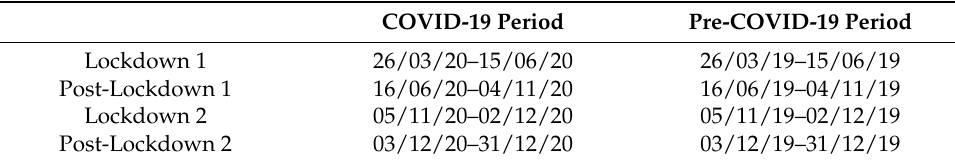
Table 1. Dates used for analysis COVID-19 Period versus Pre-COVID-19 Period. Dates based on official UK government